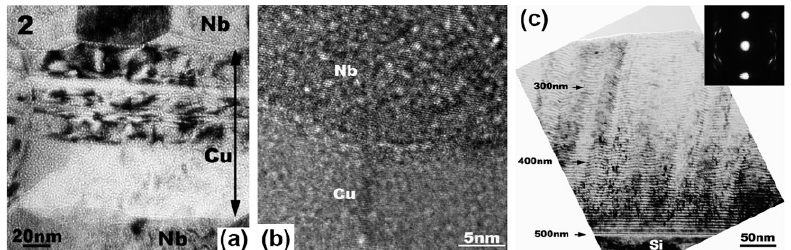
Figure 11. Under focused TEM images of He ion irradiation on multilayers with a dose of 6 × 10 16 ions/cm 2 . ( a ) Cu / V multilayers [19]; ( b ) Cu / Mo multilayers [40].